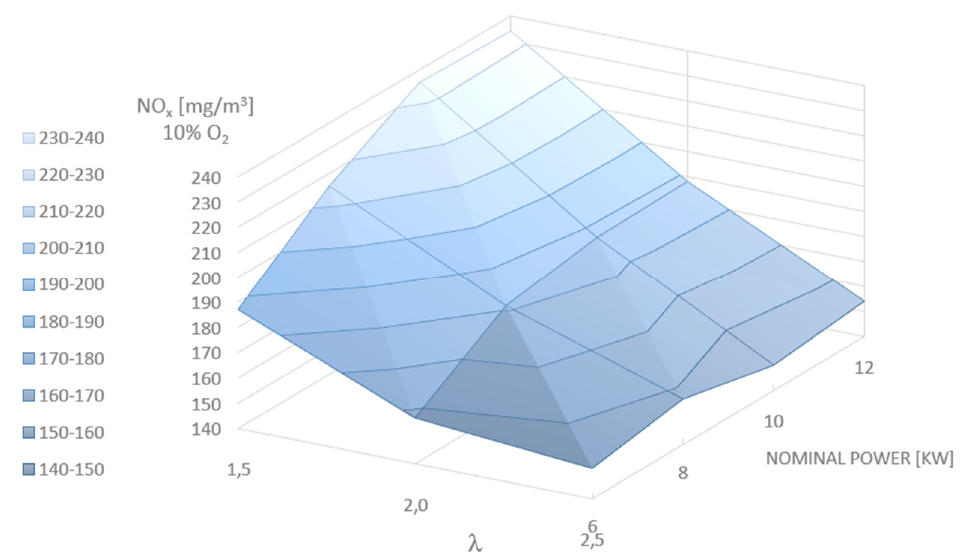
Figure 16. Numerical simulation of the combined effect of nominal power and λ on NO x concentration in the flue gases.